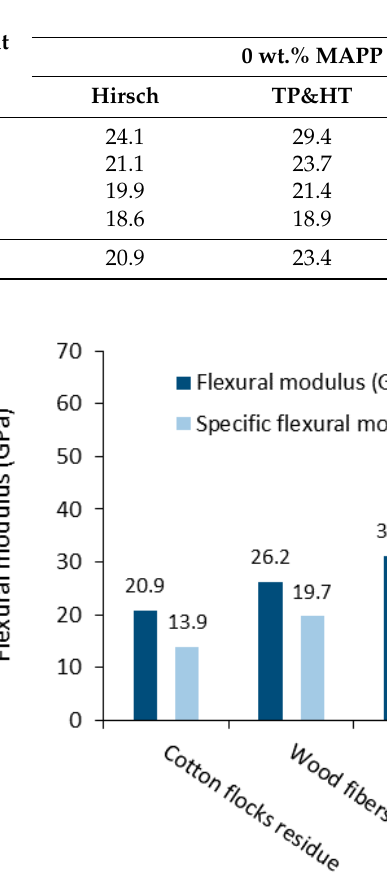
Fiber Content (wt. %) Average 20 30 50